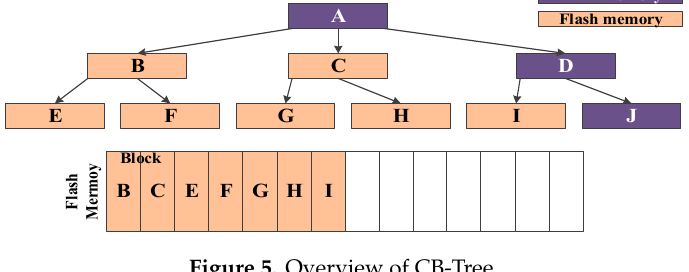
Figure 5. Overview of CB-Tree.